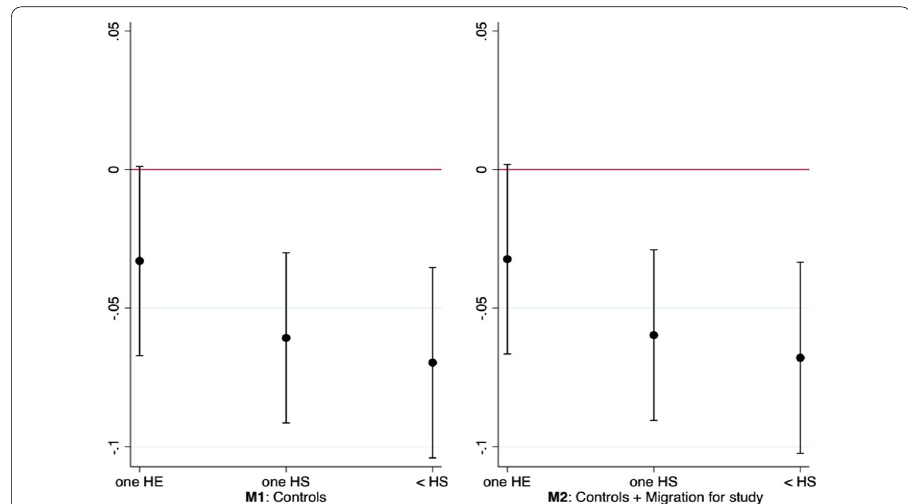
Fig. 5 Marginal change in predicted access to professional and managerial occupations as a function of parental education (ref. both HE). Bars denote 95% confidence intervals; both HE higher education degree (reference); one HE parent with a high school degree; < HS